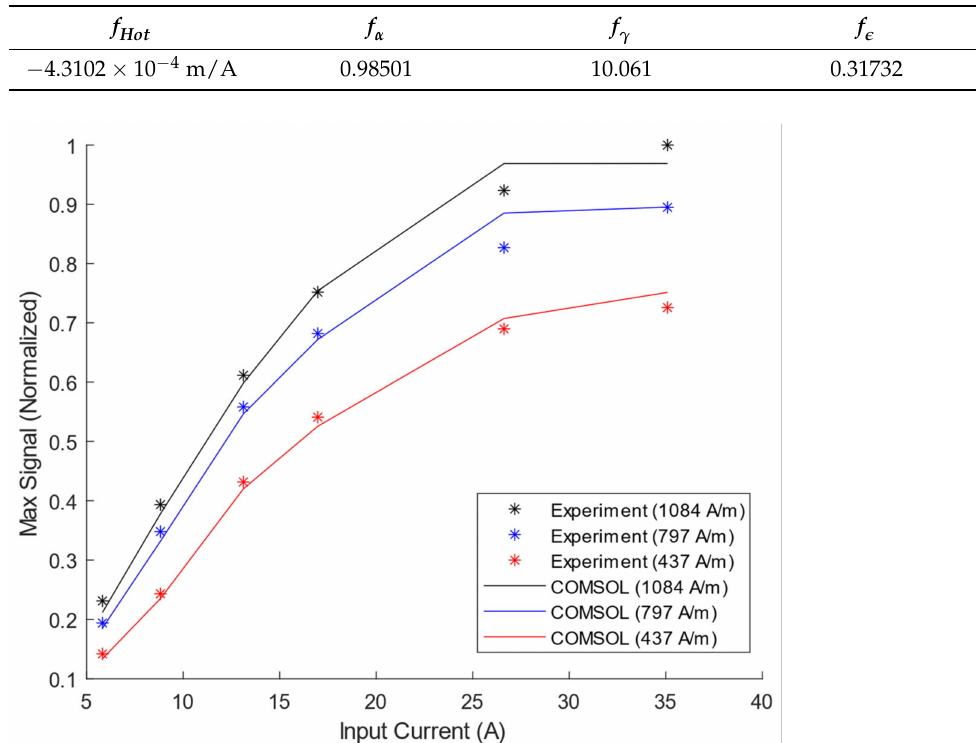
Figure 12. Optimized d MS Coefficient Values vs. Maximum Simulated Dynamic Field within the 6 y Steel Plate (Theory curve). Experimental Voltage divided by Maximum Simulated Dynamic Field vs. Maximum Simulated Dynamic Field (Experiment points). Table 1. Magnetostriction Model Factors.